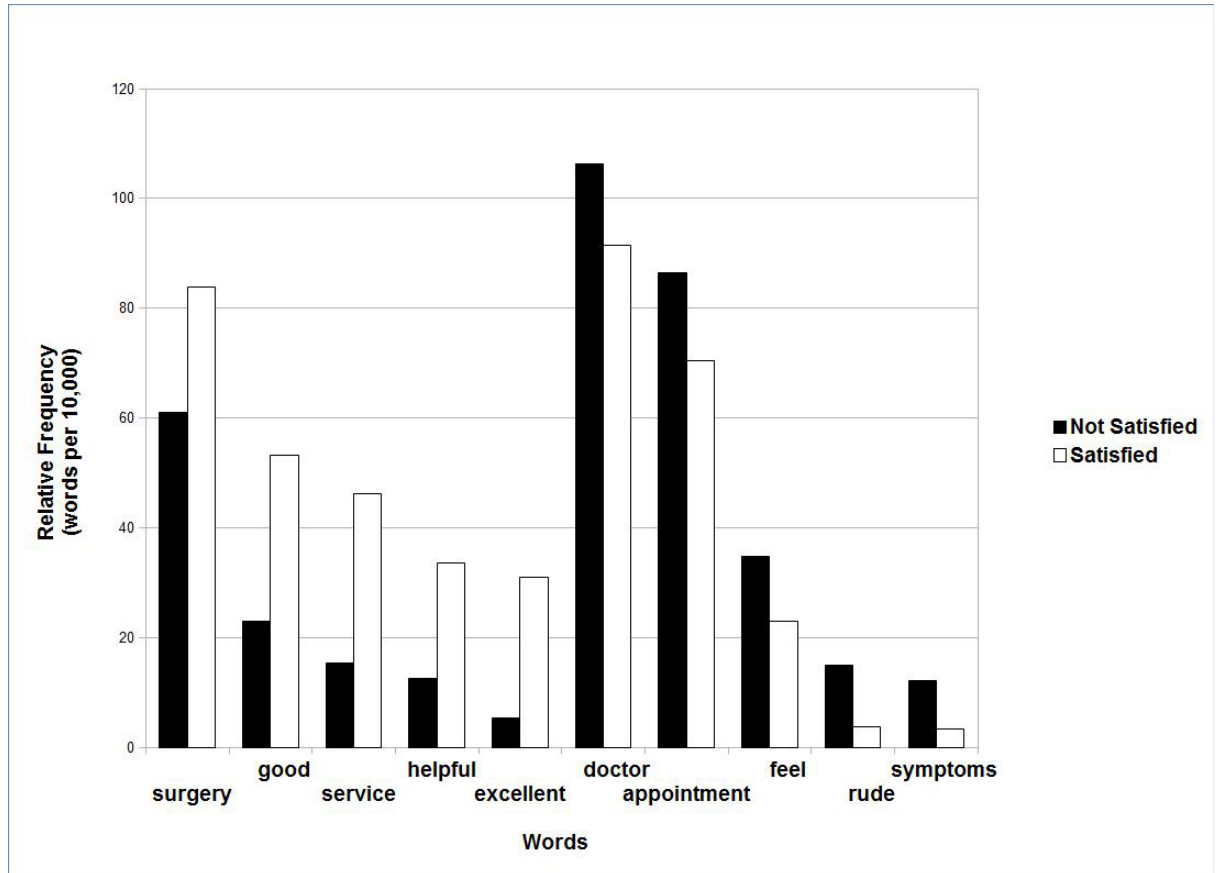
Figure 3. Word frequency by patient satisfaction.